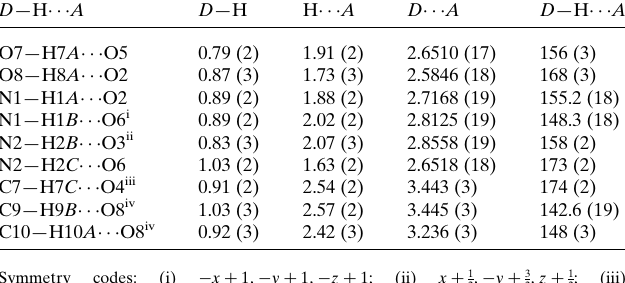
Table 1 Hydrogen-bond geometry (A˚ , (cid:6)